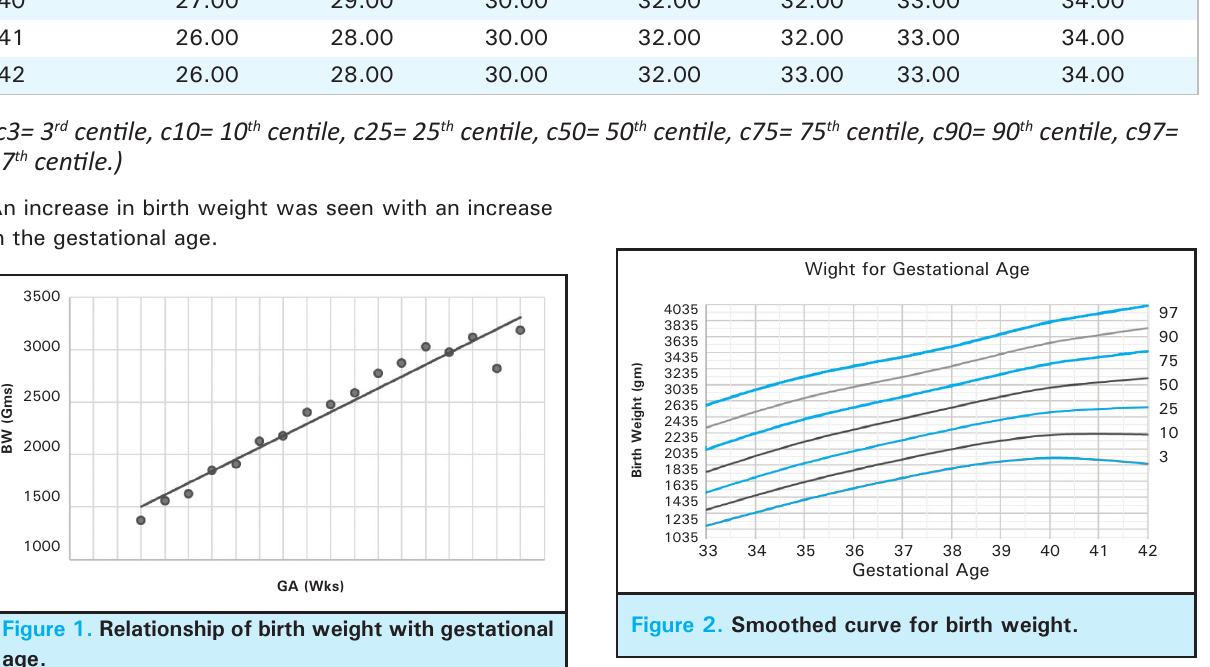
Figure 1. Relationship of birth weight with gestational age.